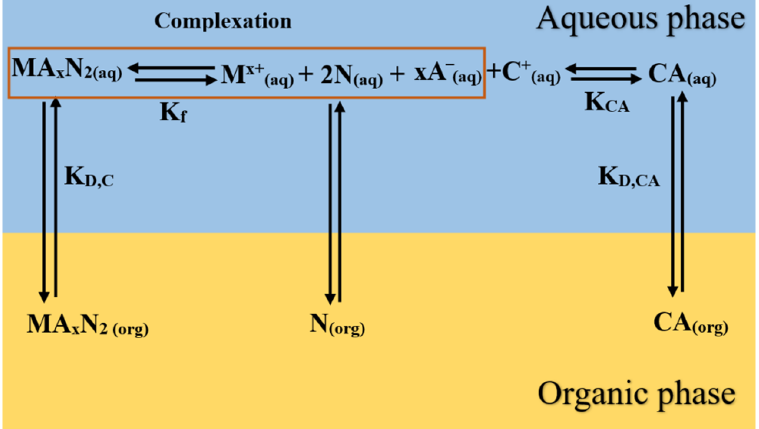
Figure 1. Proposed extraction path for the IL extractant and a neutral donor in the SX process of a certain metal.